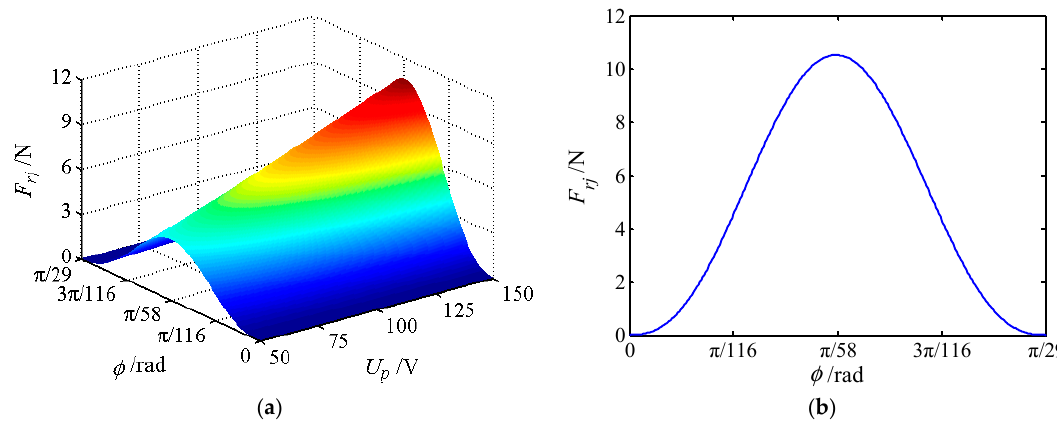
Figure 11. The force of movable tooth F cj . ( a ) The force varies with rotational angle and voltage; ( b ) force sectional view at U p = 150 V.